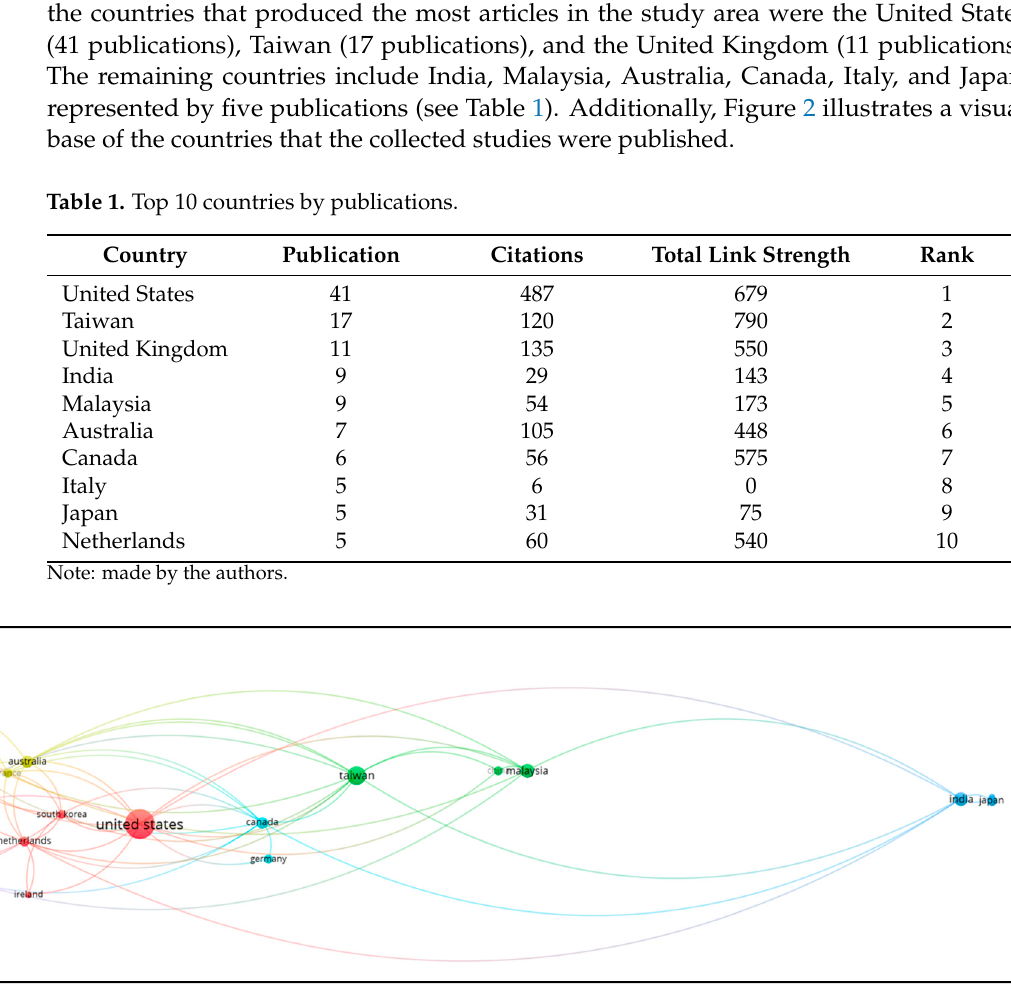
Figure 2. Cluster distribution of countries that published at least 2 documents. Note: made by the authors.